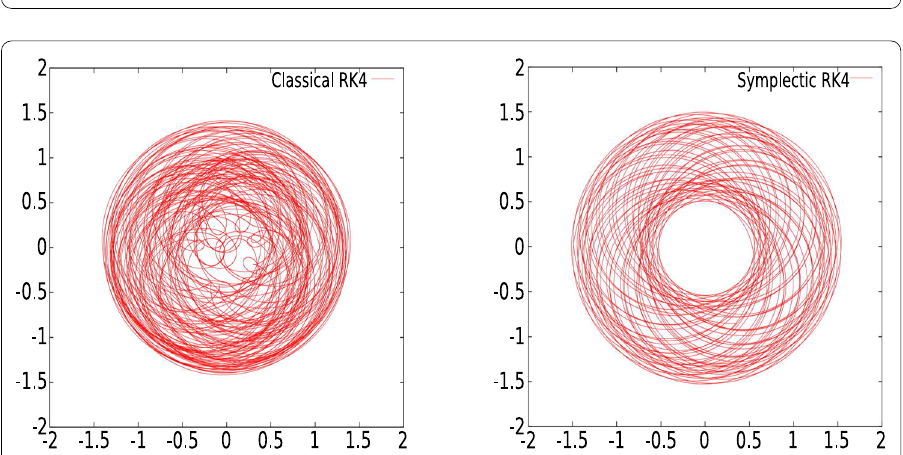
Fig. 10 Computed trajectories with RK4 and RK4sym. Angulary perturbed initial configuration